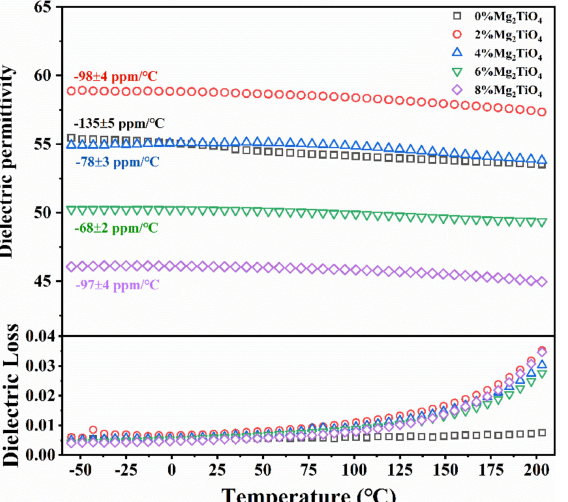
Figure 4. The dielectric response temperature characteristics of x% Mg 2 TiO 4 -CSZT thin films in the range of − 55~205 ◦ C.